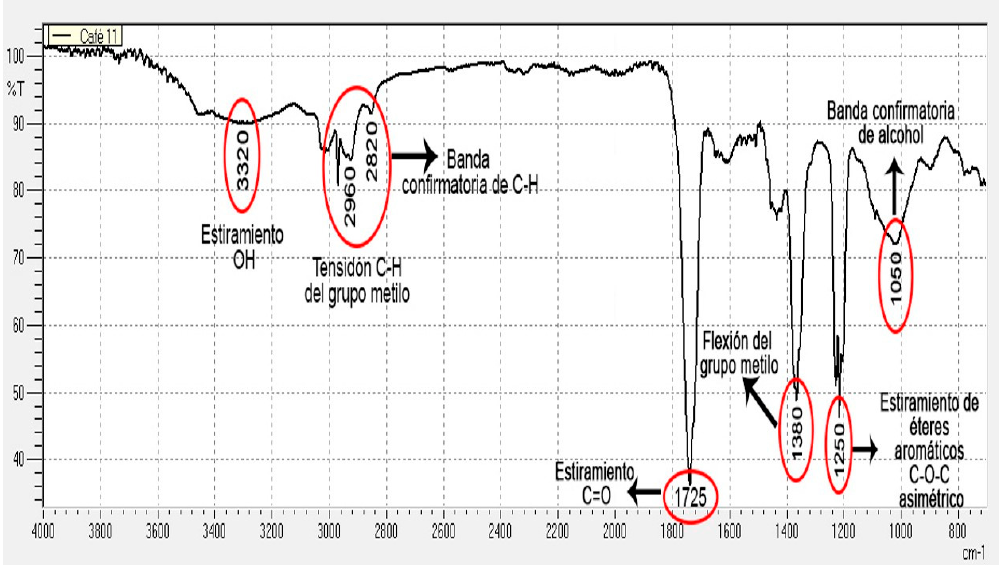
Figure 1. Infrared spectrum of the co ff ee pulp before the application of the bioadsorption process of chromium (Cr) (VI).